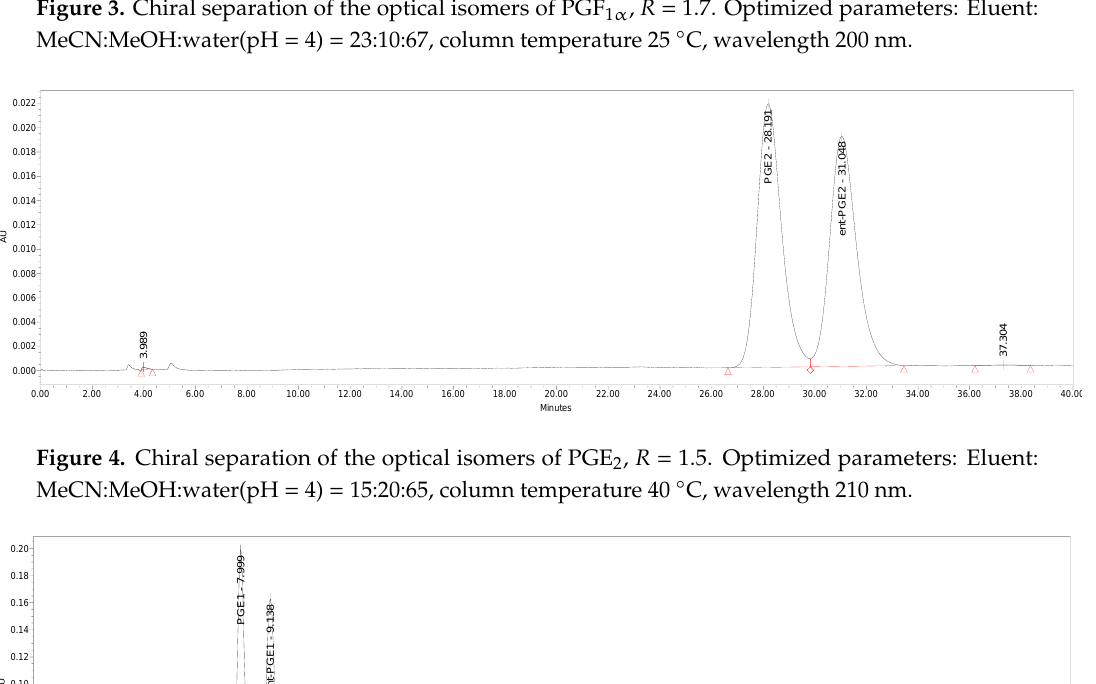
Figure 3. Chiral separation of the optical isomers of PGF 1α , R = 1.7. Optimized parameters: Eluent: